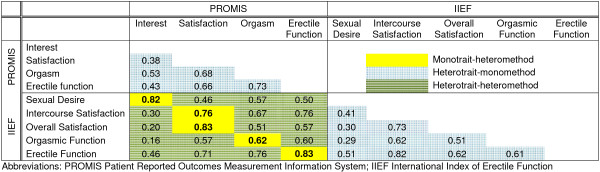
Correlations for men (N=390).